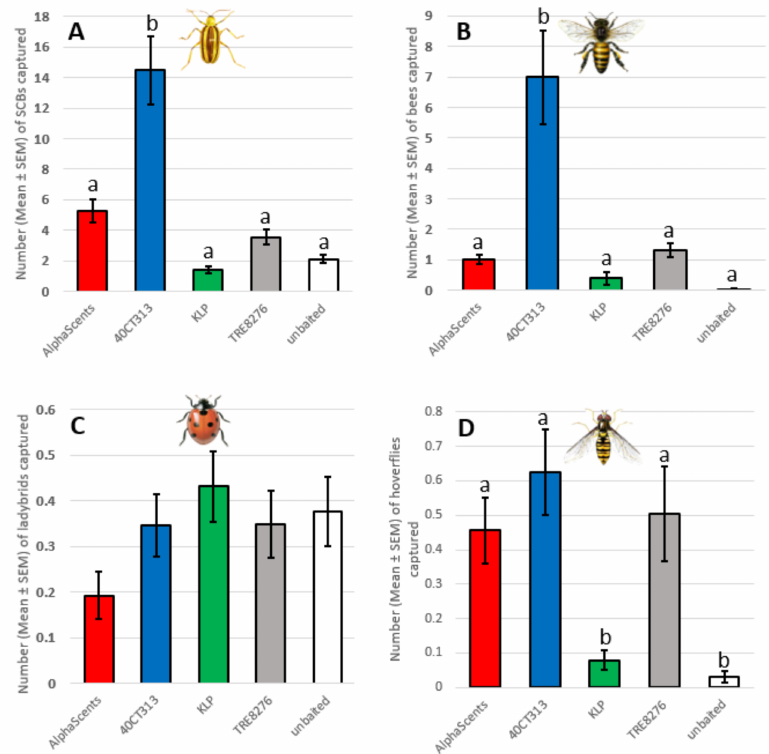
Figure 3. Number of SCBs, ladybirds, bees and hoverflies captured in traps baited with different lures (ANOVA, ( A ) SCB—F 4,505 = 22.02, p < 0.001; ( B ) bees—F 4,505 = 15.55, p < 0.001; ( C ) ladybirds— F 4,505 = 1.55, p = 0.19; ( D ) hoverflies—F 4,505 = 7.49, p < 0.001). Different letters above bars